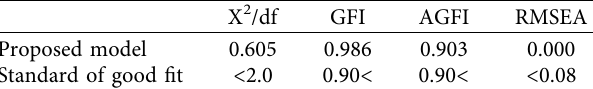
Figure 2: Te intensity of standardized abnormal perception experienced in the congruent and incongruent conditions. In the congruent condition, there were signifcant diferences between heaviness (frst) and heaviness (second), and between heaviness (frst) and heaviness (third). In the incongruent condition, there was a signifcant diference between extra limb (frst) and extra limb (third). In the congruent condition and the incongruent condition, there was a signifcant diference in pain between the frst and third time points. Table 2: Te ft index values indicated that the model provided a good representation of the